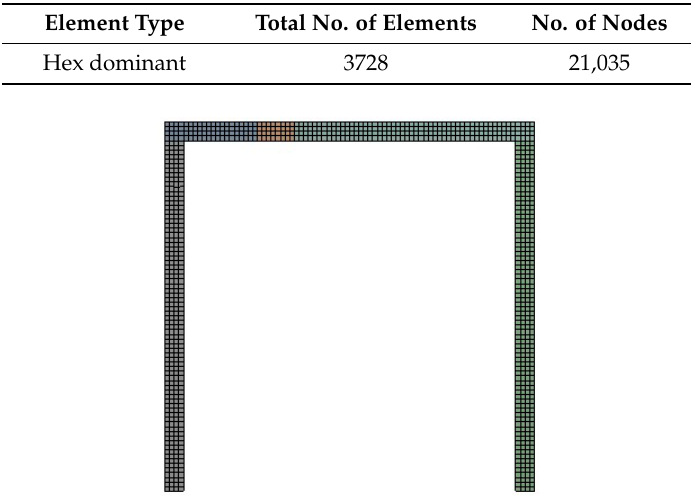
Table 2. The message of elements and nodes of the ANSYS simulation.